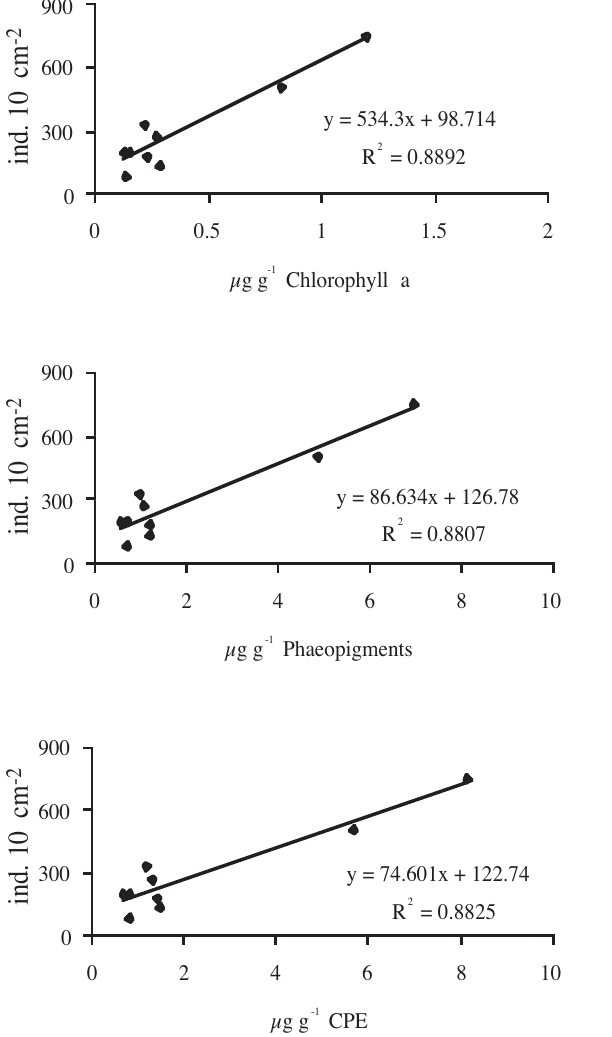
F IG . 7. – Linear regression plots of total meiobenthic abundances in the upper 5 cm of the sediment versus Chlorophyll a , Phaeopigments and CPE (P < 0.001).